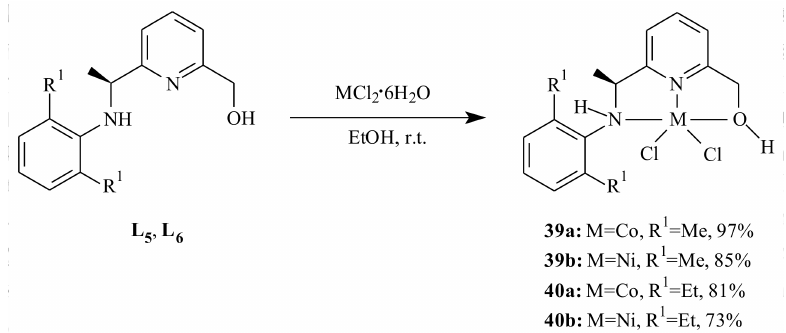
Scheme 6. Synthesis of (amino)pyridinyl alcoholato complexes of Co and